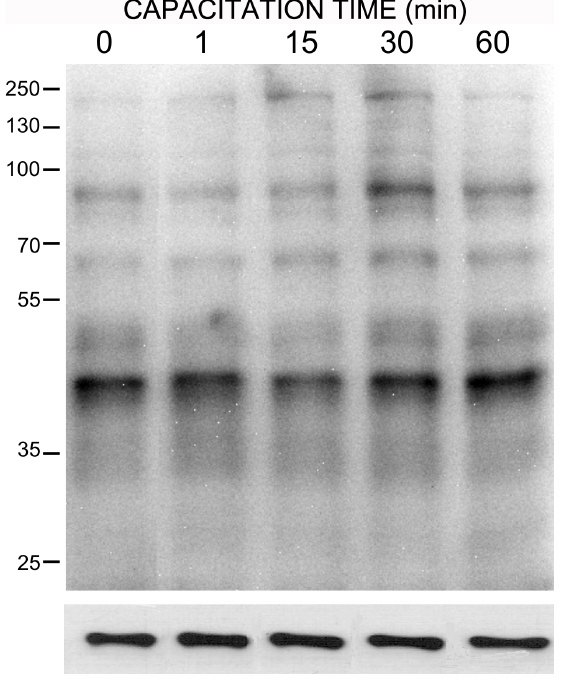
Figure 6. Phosphorylation of threonine residues of human sperm proteins during capacitation. Human sperm obtained in NCM were then resuspended in RCM and incubated for the indicated times. Then, samples were processed for western blot analysis and labeled with a monoclonal anti-p-Thr antibody. The lower panel indicates load control. The immunoblot shown is representative of a total of three different experiments with three different donors.